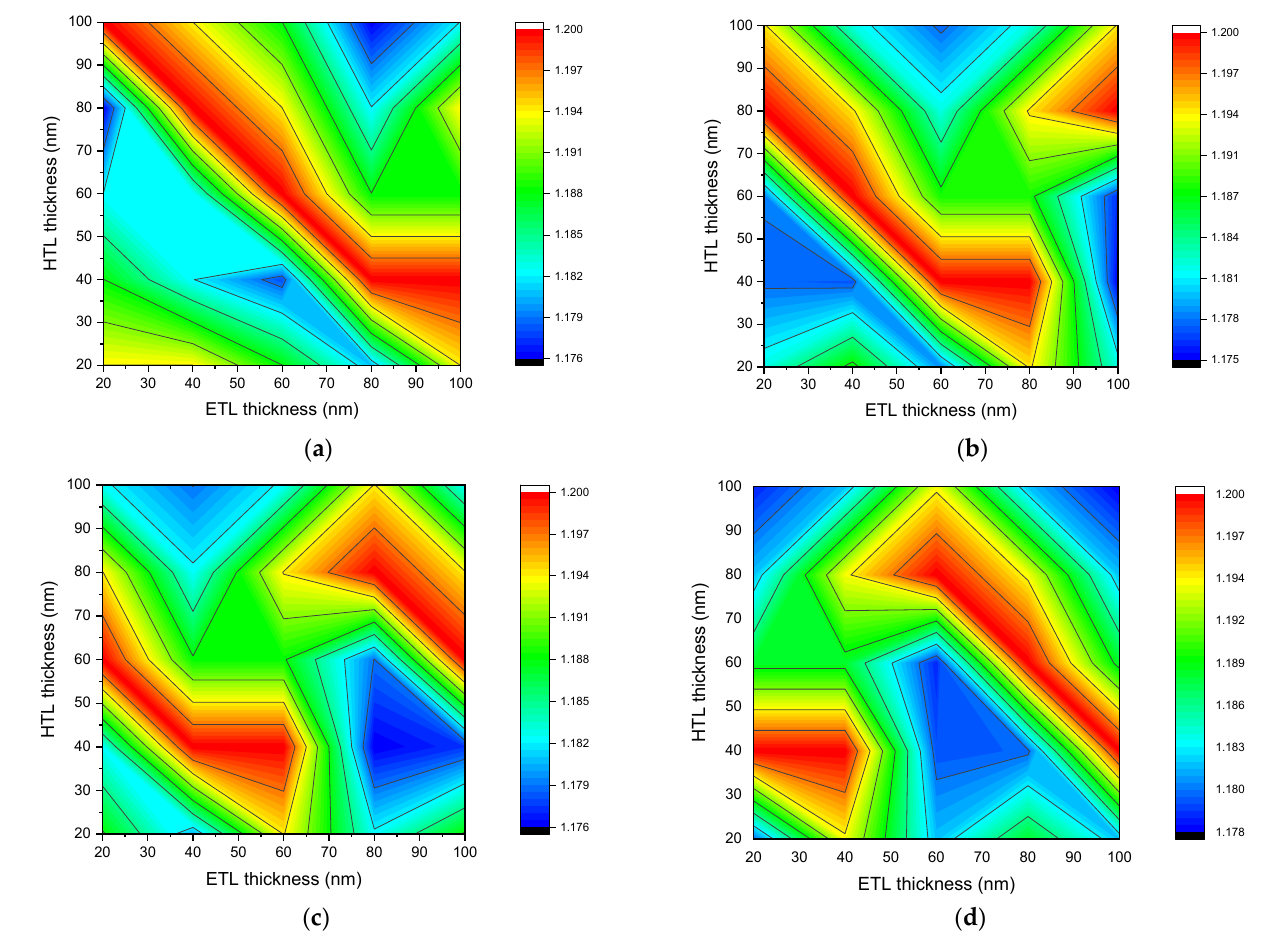
Figure 3. Dependence of open-circuit voltage of n-ZnO/p-CH 3 NH 3 PbI 3 /p-NiO x solar cell with perov- skite layer thickness of 200 nm ( a ), 400 nm ( b ), 600 nm ( c ), and 800 nm ( d ) on the thicknesses of the ETL and the HTL layers.